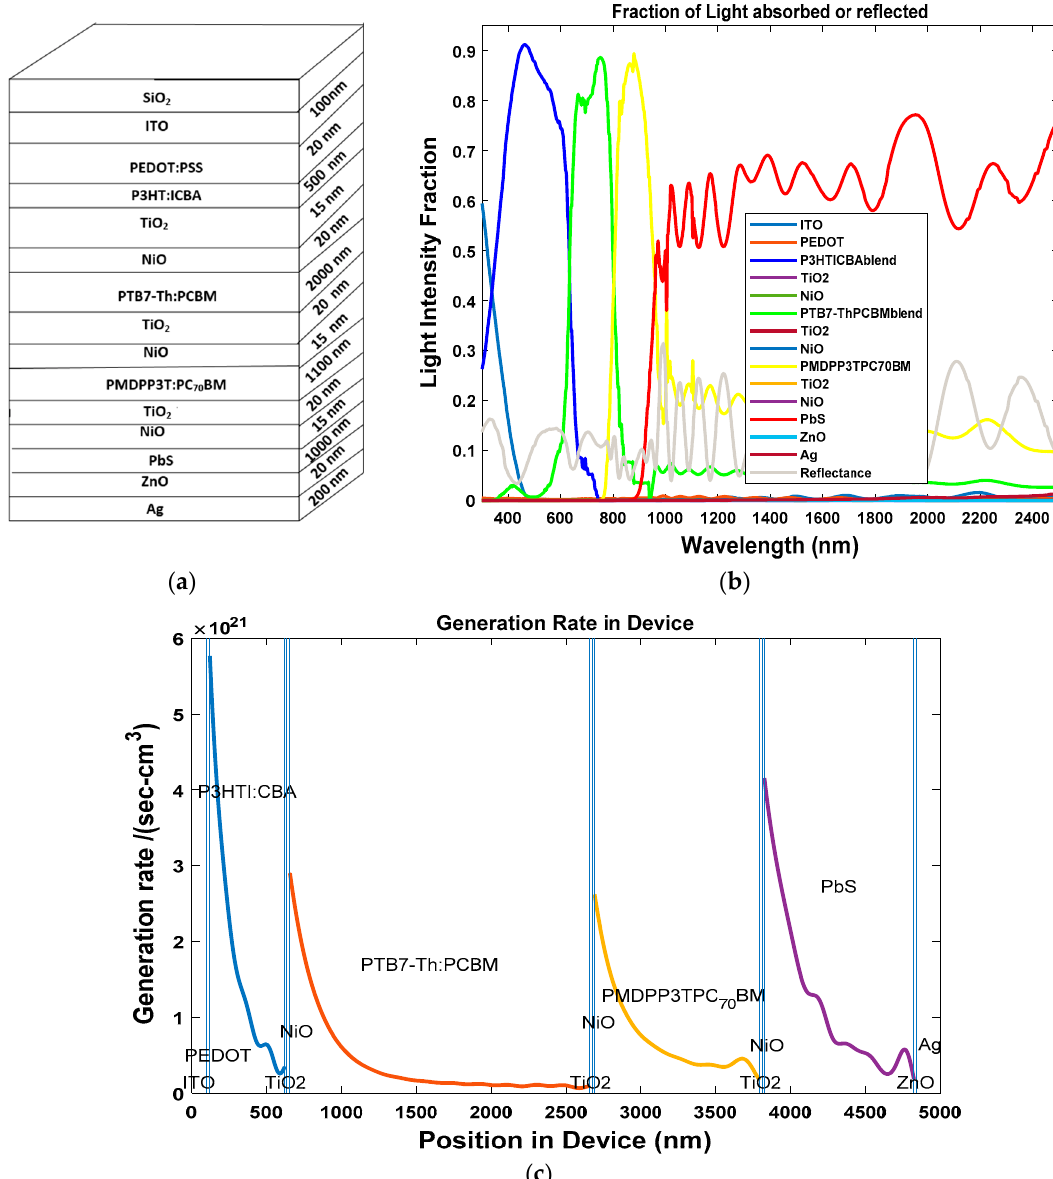
Figure 10. ( a ) Stack diagram; ( b ) variation of light intensity versus wavelength; and ( c ) exciton generation rate vs. position in device for two-junction hybrid solar cell.